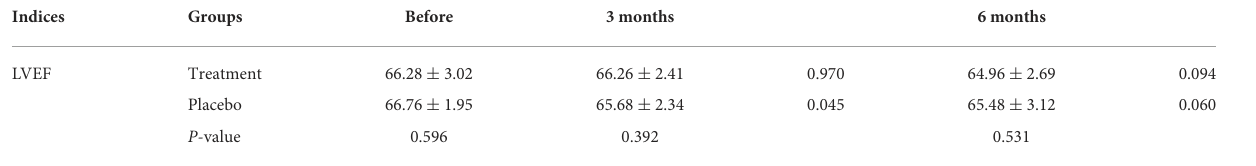
TABLE 3 Echocardiographic measurements ( ¯ X ± SD)